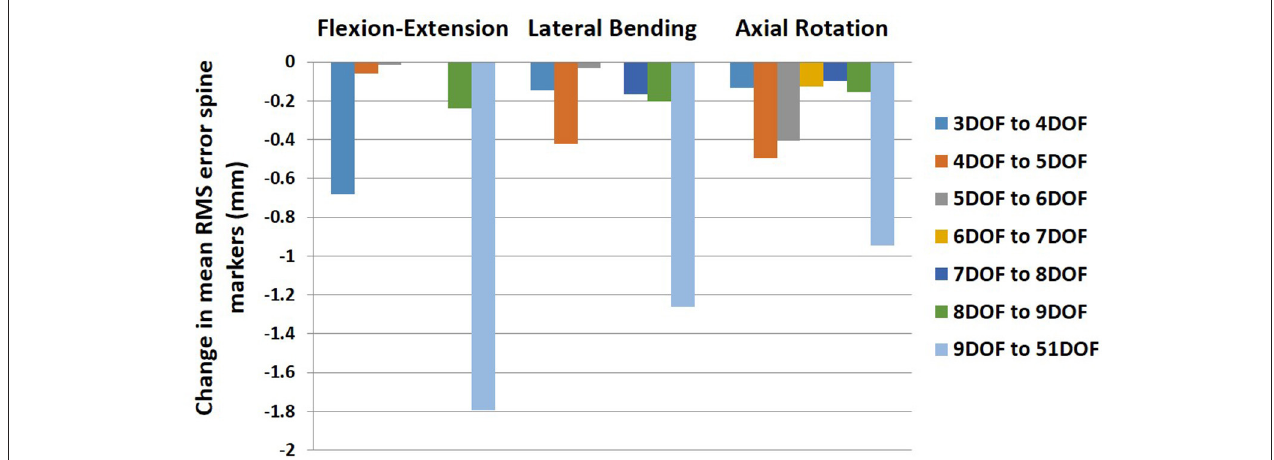
FIGURE 6 | Change in mean RMS error of spine markers for all pairs of sequential kinematic constraints in all tasks (flexion–extension, lateral bending, and axial rotation). RMS, root mean square.